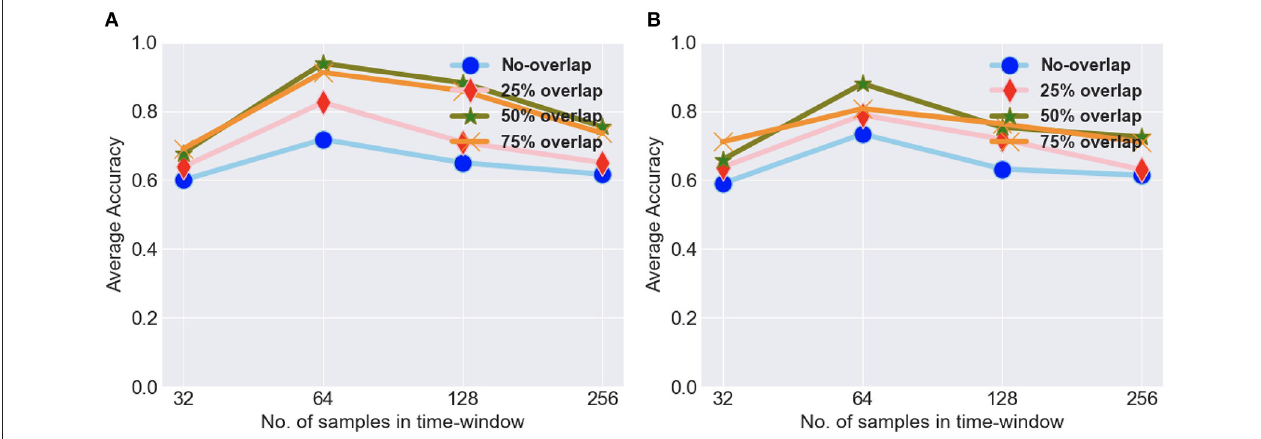
FIGURE 7 | (A) The average intra-subject accuracy for different timewindows and overlap values for scalogram data. (B) The average intra-subject accuracy for different timewindows and overlap values for raw data.